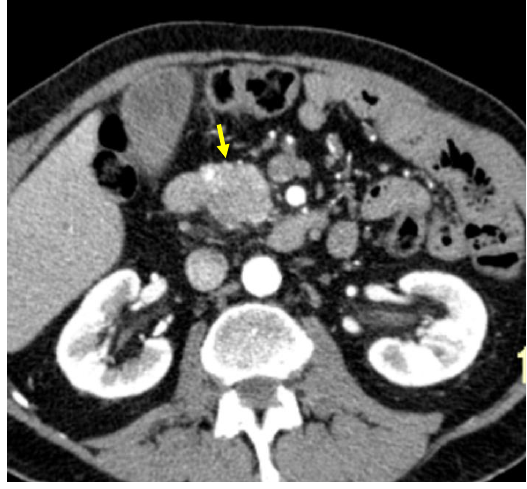
Figure 2. Pancreatic lesion with well-defined margins (arrow) on CT examination in pancreatic contrast phase.